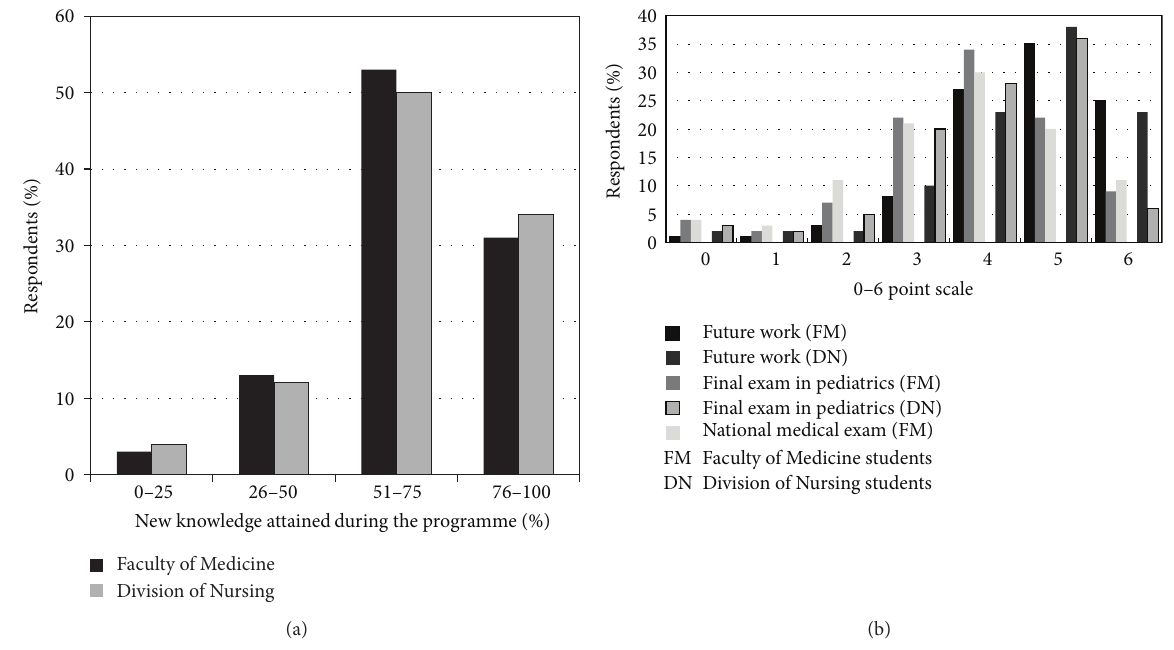
Figure 3: Students’ opinion on knowledge attained during the programme. (a) Evaluation of novelty of knowledge attained during the programme. (b) The usefulness of the new knowledge in students’ future work and preparation for exams evaluated on 0–6-point scale.